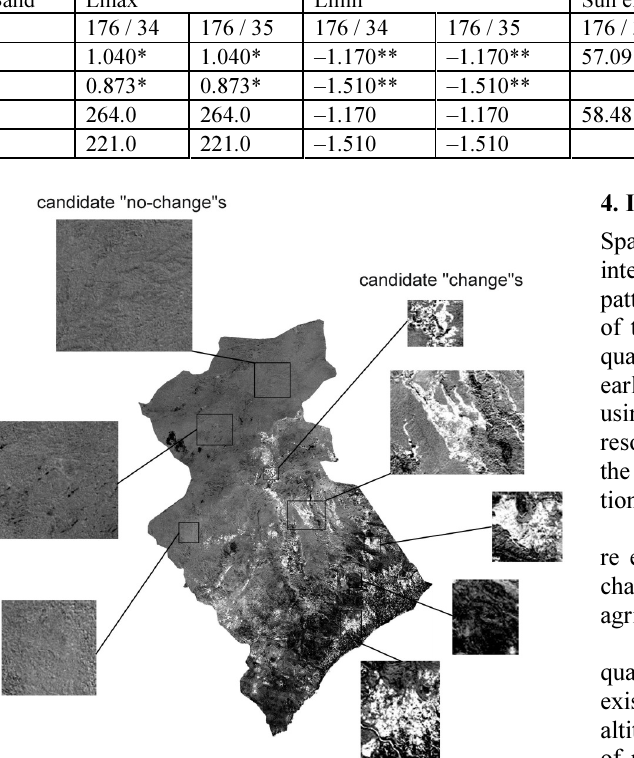
Table 1. Atmospheric correction parameters (*offset, **gain) Band